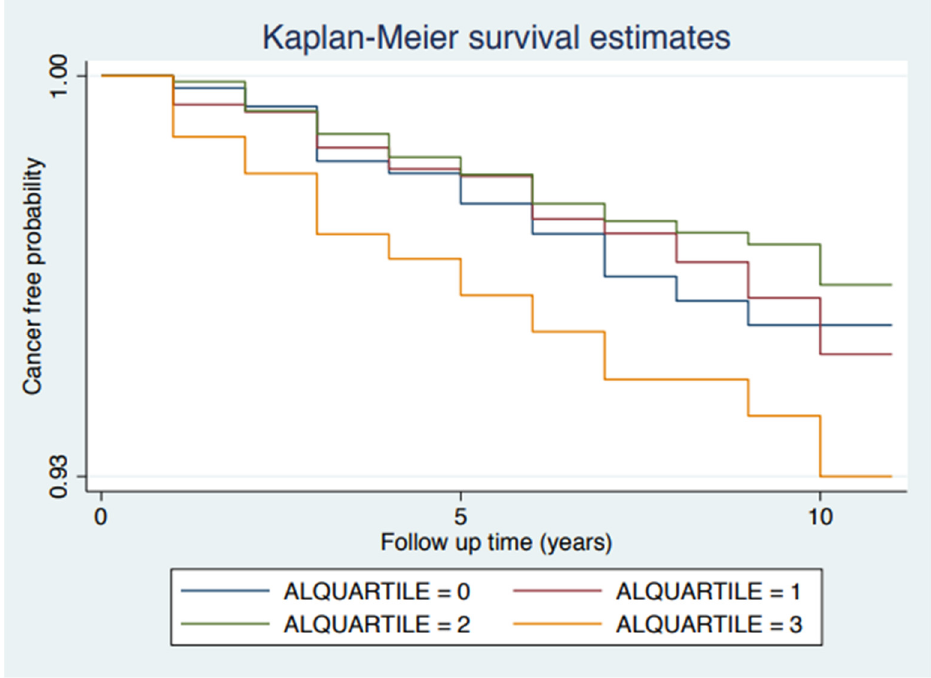
6 of 12 Table 4. Associations between AL category and overall cancer risk. AL Category Unadjusted (HR, 95% CI)